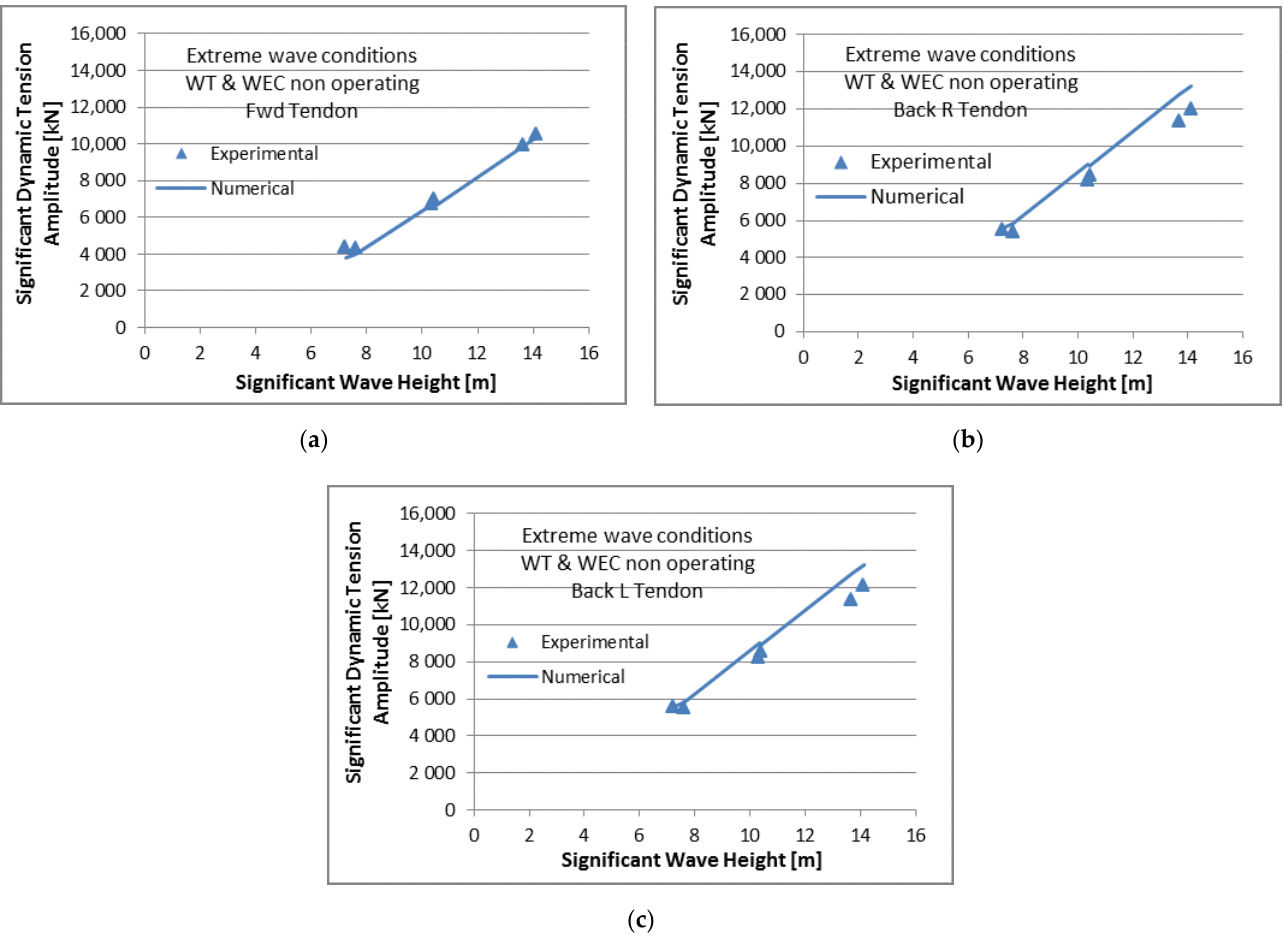
Figure 16. REFOS mooring dynamic tensions comparisons for extreme conditions at the North Sea location: ( a ) forward tendon; ( b ) backward left tendon; ( c ) backward right tendon.